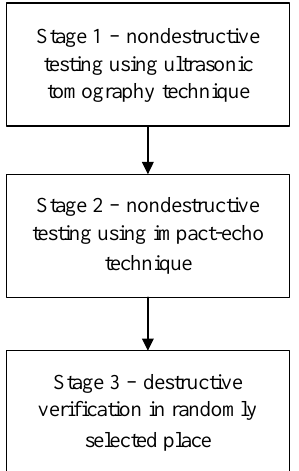
Fig. 4. General diagram illustrating methodology for non- destructive identification of thickness of unilaterally acces- sible concrete element by means of acoustic ultrasonic tomography and impact-echo techniques